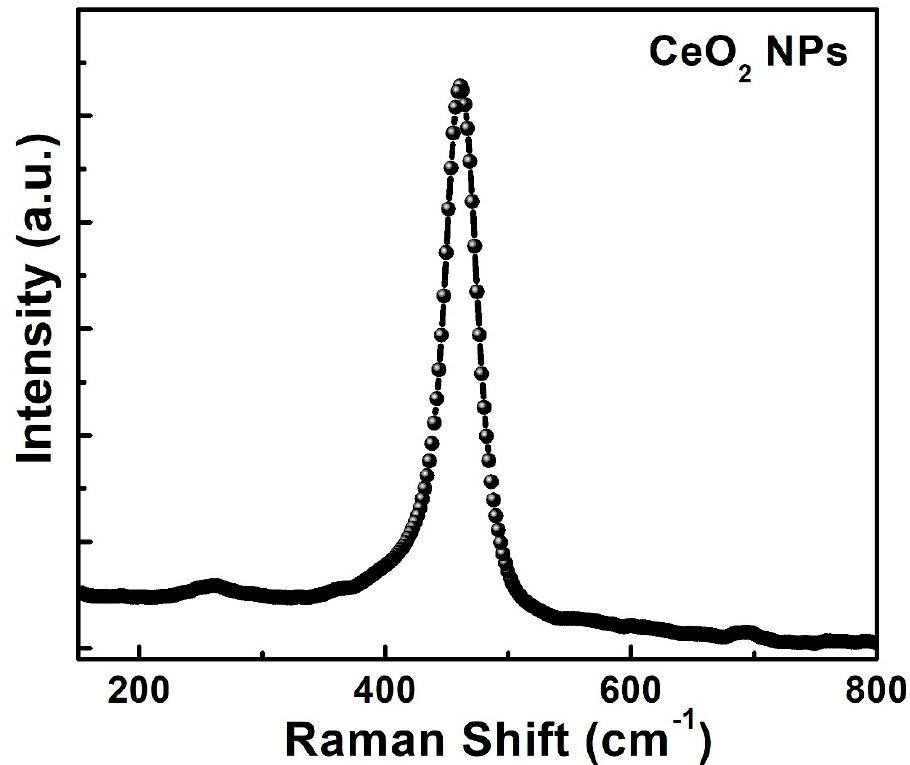
Figure 3. Room temperature Raman spectrum of CeO 2 NPs.